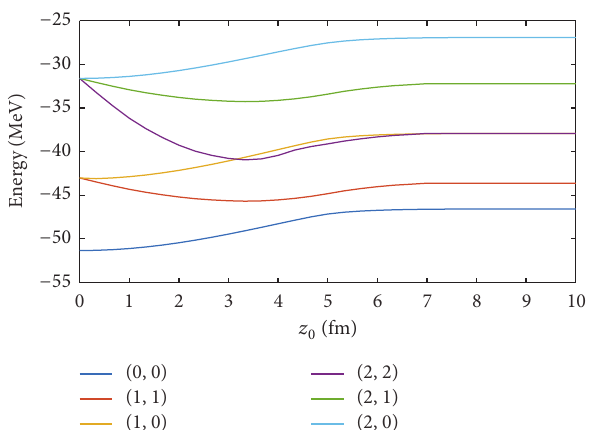
Figure 5: Variations of the eigenvalues in 𝑧 -axis with the distance between the two cluster